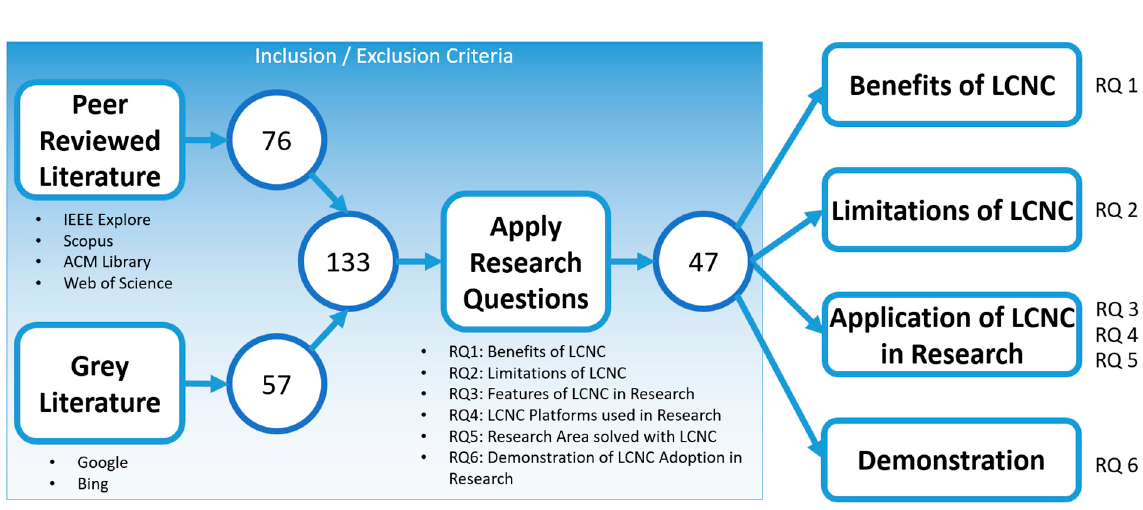
Figure 2. Methodology for reviewing the existing literature on LCNC platforms to answer research questions.